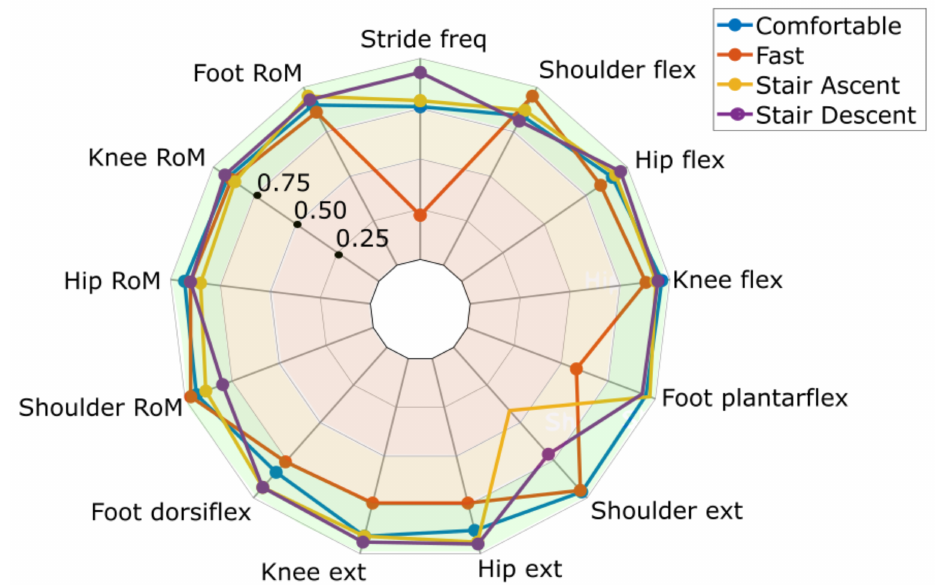
Figure 4. Intraclass correlation coefficients (ICCs) for test-retest measurements of peak angles, range of motion (RoM), and stride frequency during comfortable gait (blue), fast gait (red), stair ascending (yellow), and stair descending (purple). ICC < 0.5 (red shaded area) represents poor reliability, ICC from 0.5 to 0.7 represents moderate reliability, and ICC < 0.75 (green shaded area) represents good to excellent test-retest variability.